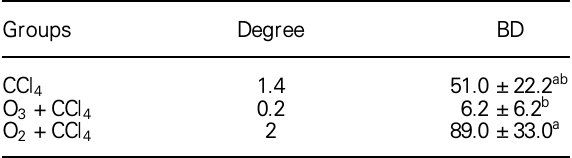
Table 1. Evaluation of the general hepatic damage in the three groups challenged with CCl 4 Groups